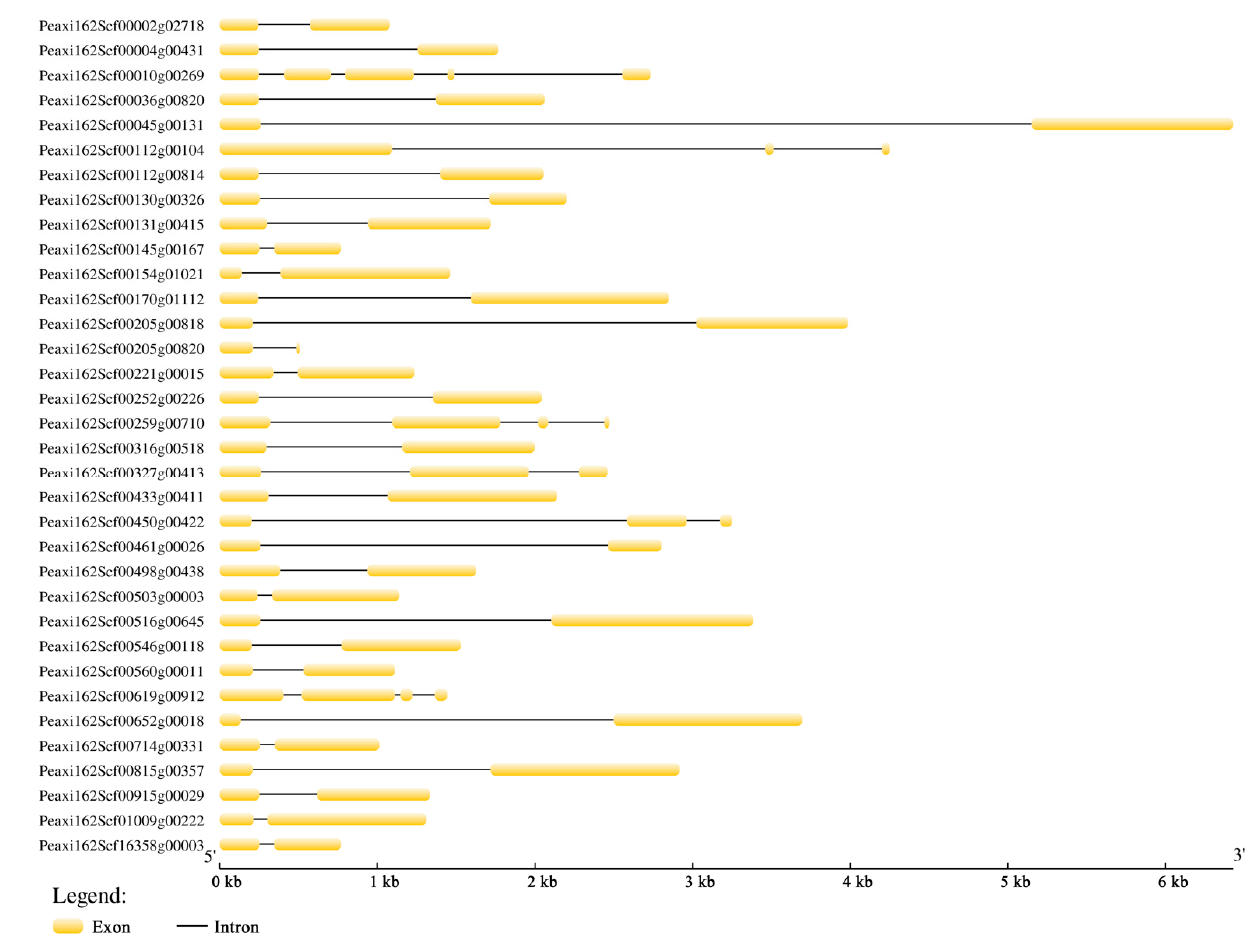
Figure 1. Gene structure analysis of 34 petunia HSFs. The exons and introns are indicated by the yellow boxes and black lines, respectively.